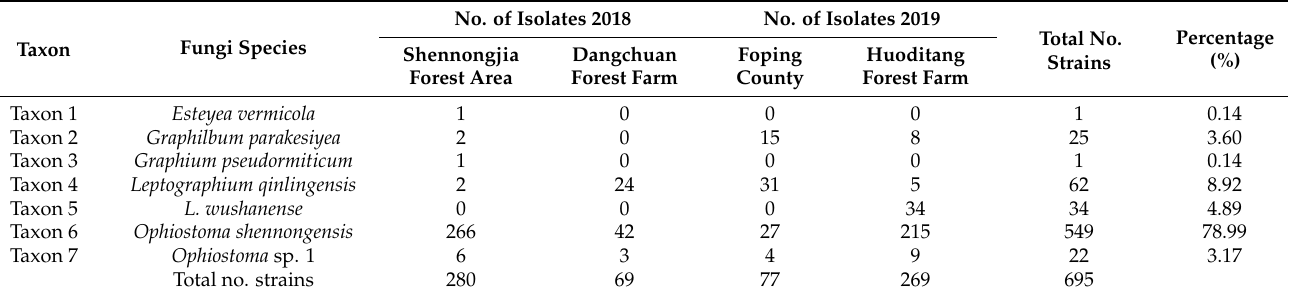
Table 3. Strain numbers and percentage of various ophiostomatoid fungi isolated from D. armandi and their galleries in western